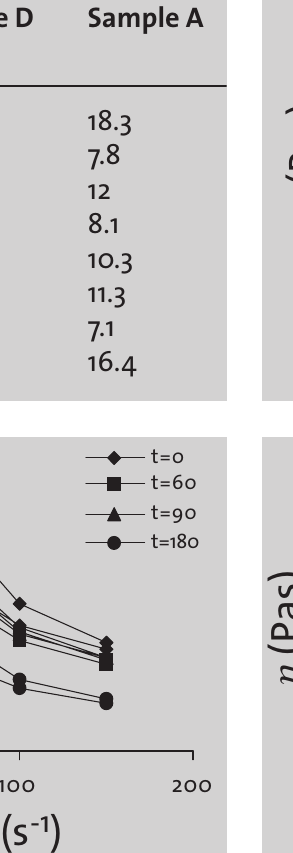
Table 2 (left above): Thixotopy degree %. Figure 3 (right above): Apparent viscosity versus shear rate for sample D at different storage times. Figure 4 (left below): Apparent viscosity versus shear rate for sample A at different storage times. Figure 5 (right below): Apparent viscosity versus storage time for sample D and A at 100s -1